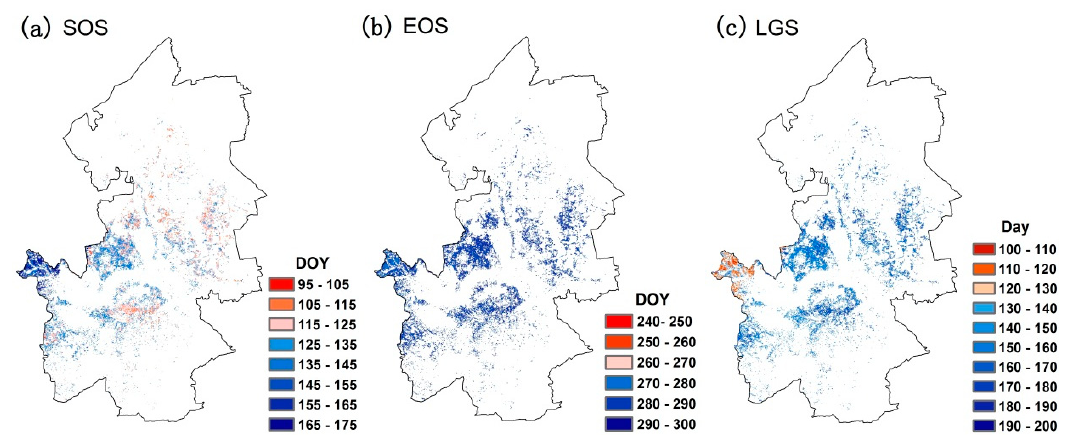
Figure 6. The spatial distributions of the multiyear mean value of ( a ) the SOS, ( b ) the EOS, and ( c ) the length of the green season.